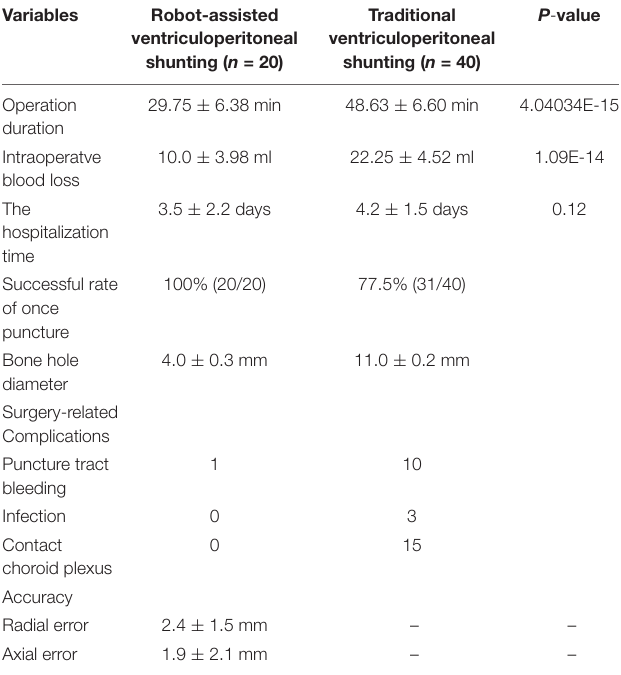
TABLE 2 | Comparison of clinical characteristics in the robot-assisted and traditional surgery groups. Variables Robot-assisted Traditional ventriculoperitoneal ventriculoperitoneal shunting ( n = 20) shunting ( n =